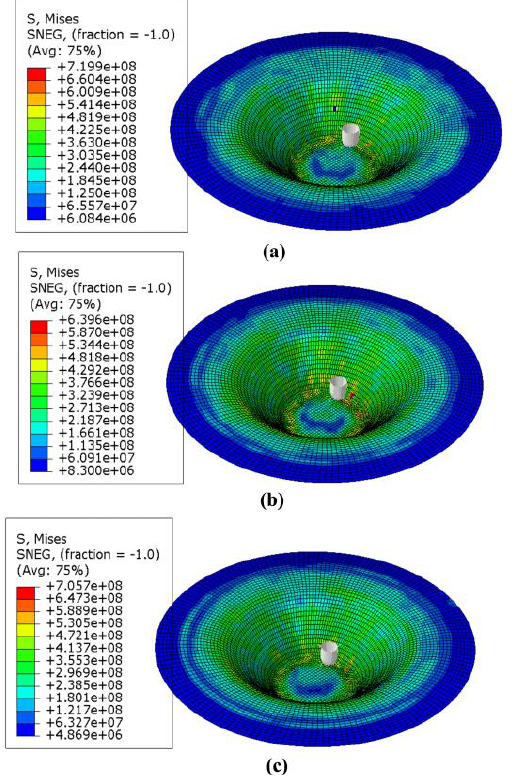
Figure 14. von Mises stress distribution for DD material model at ( a ) no fluid pressure, ( b ) pressure 0.2 bar and ( c ) pressure 0.4 bar.